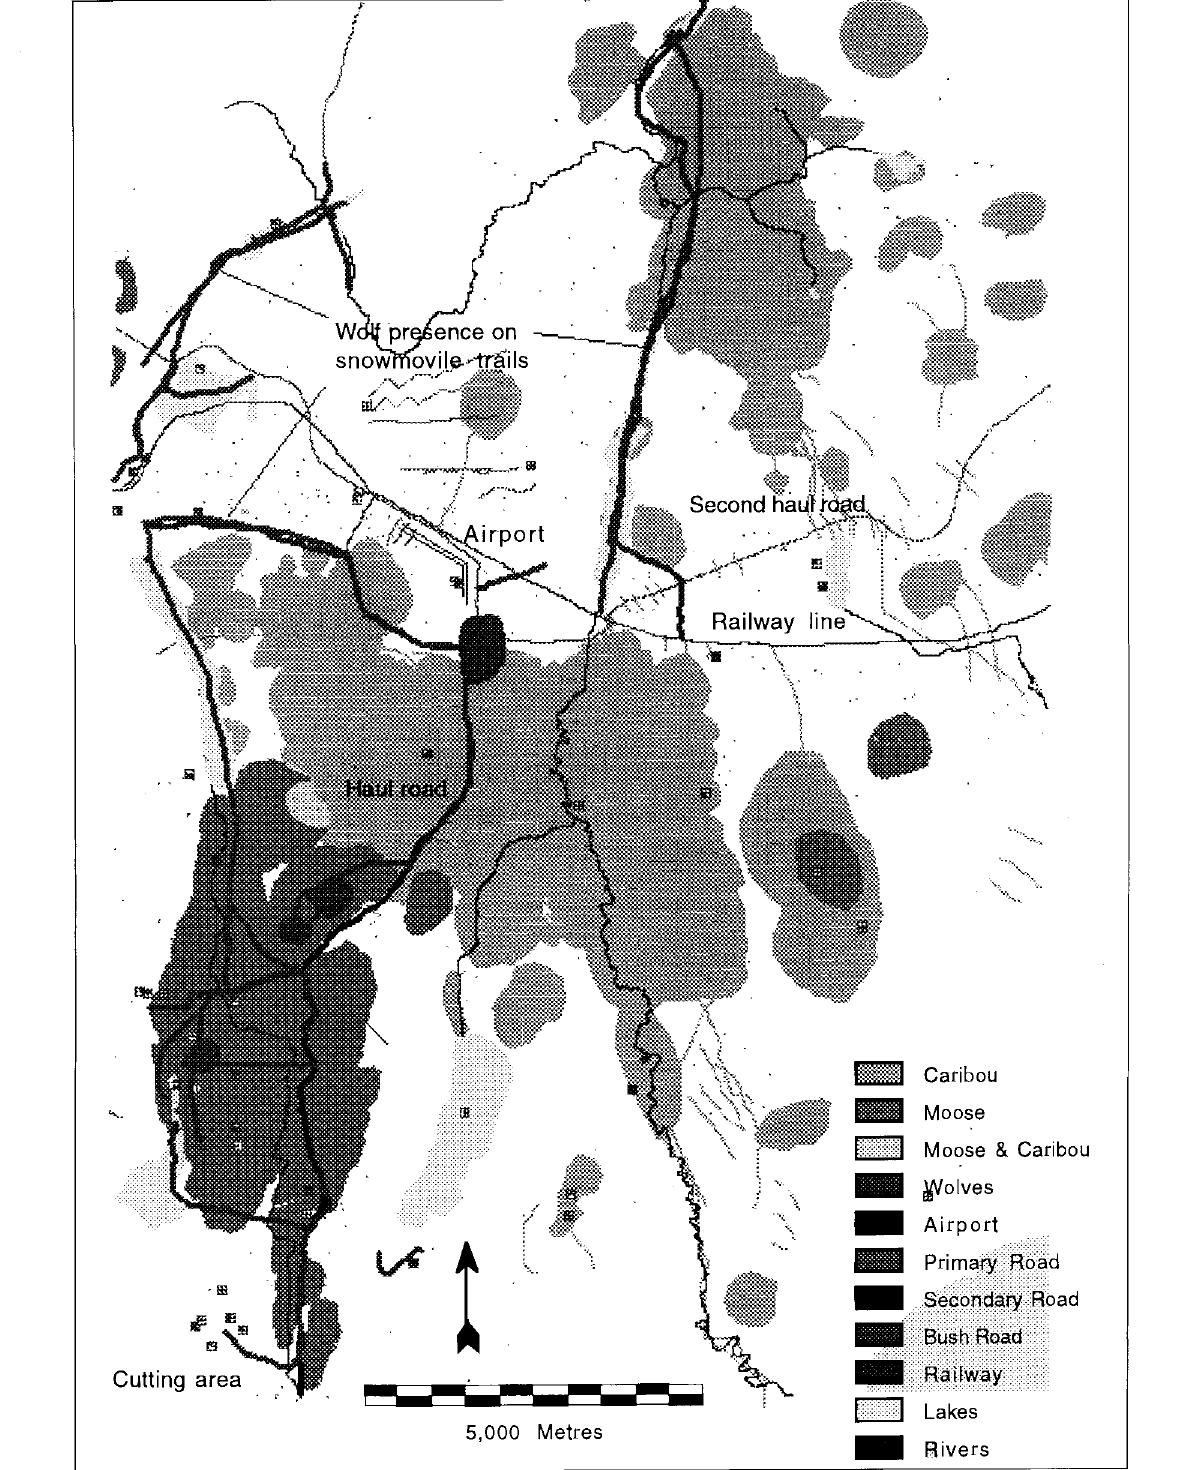
Fig. 6. Three years' combined track data showing habitat partitioning by caribou and moose, with wolves, traveling roads and snowmobile tracks, mostly associated with moose rather rhan